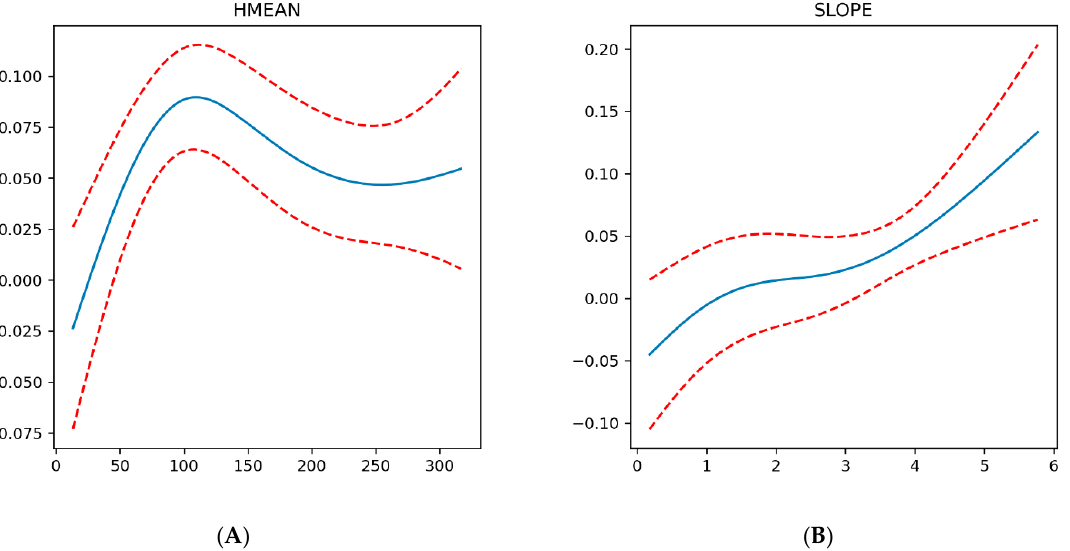
Figure 12. Dependence of rill erosion density on topography factors—average height (m) ( A ) and average slope steepness (deg) ( B ) in the basin.